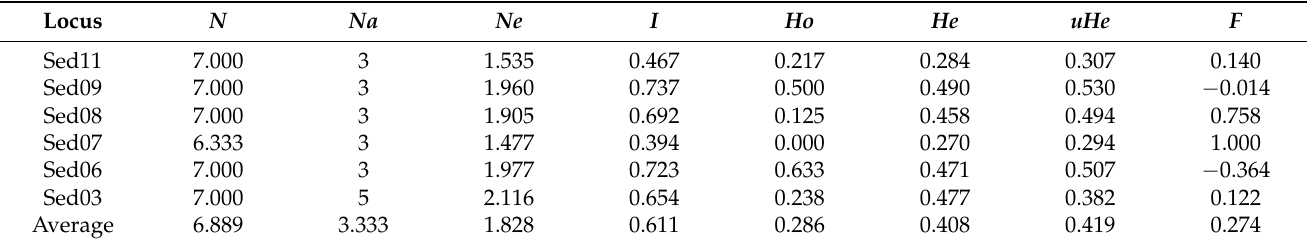
Table 2. The estimated polymorphic information on chayote using SSR